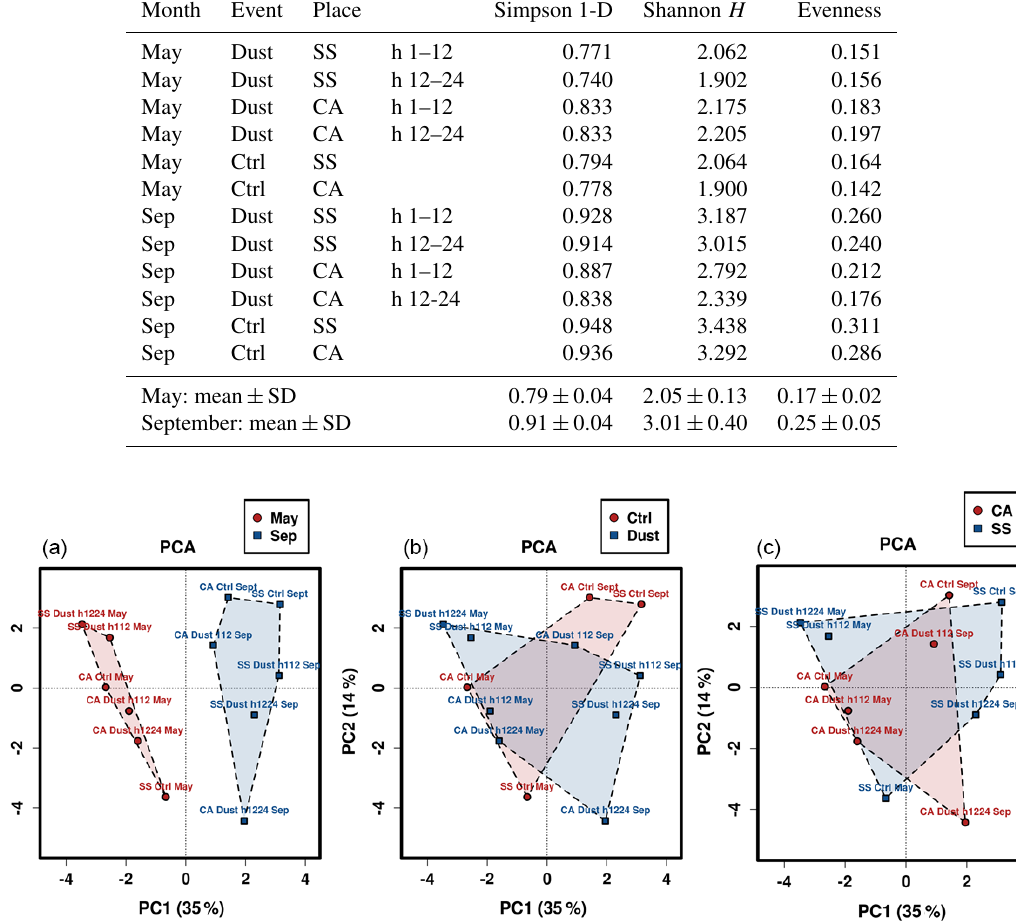
Figure 4. Principal component analysis (PCA) ordination plot of the bacterial community compositional data. Polygons encompassing the positions of three different variables are drawn to visualize sampling month (a) , ongoing meteorological event (b) , or sampling location (c)